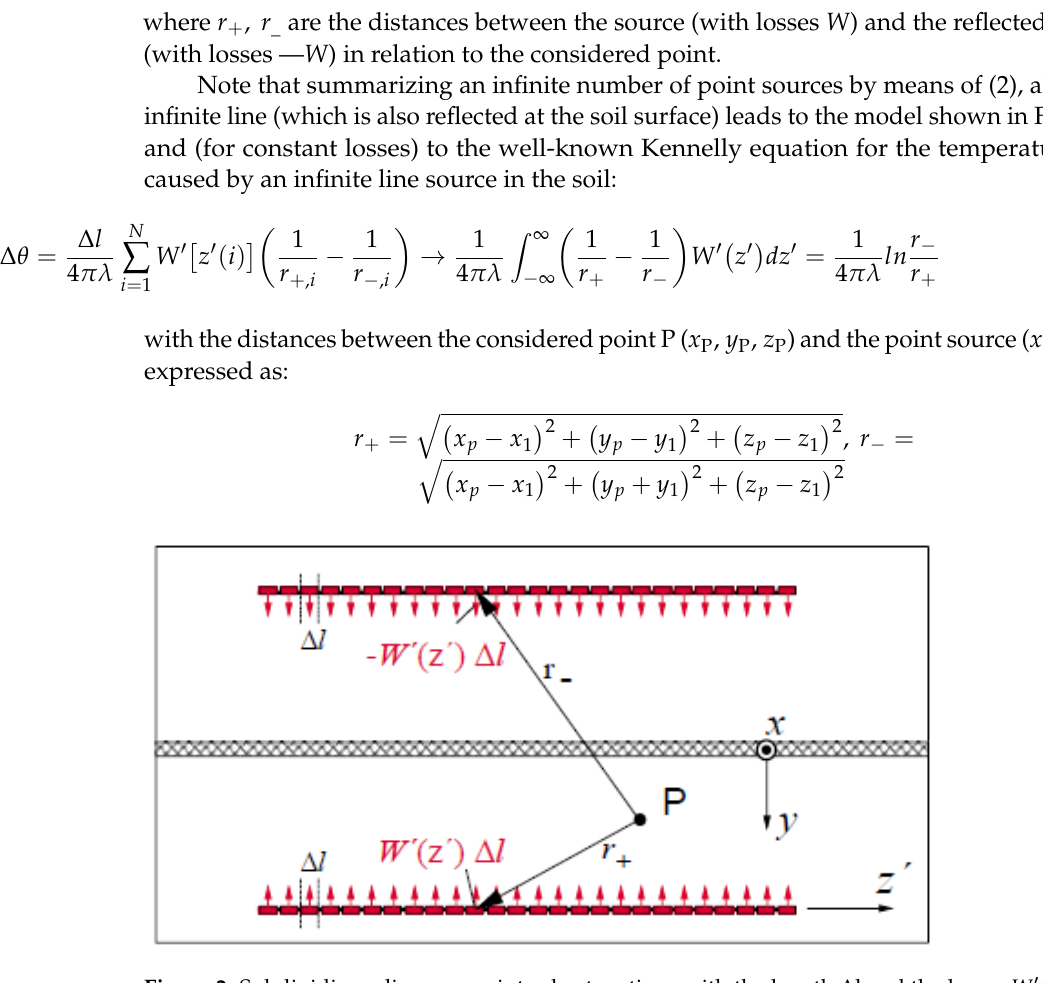
Figure 2. Subdividing a line source into short sections with the length Δ l and the losses W ’(z’) Δ